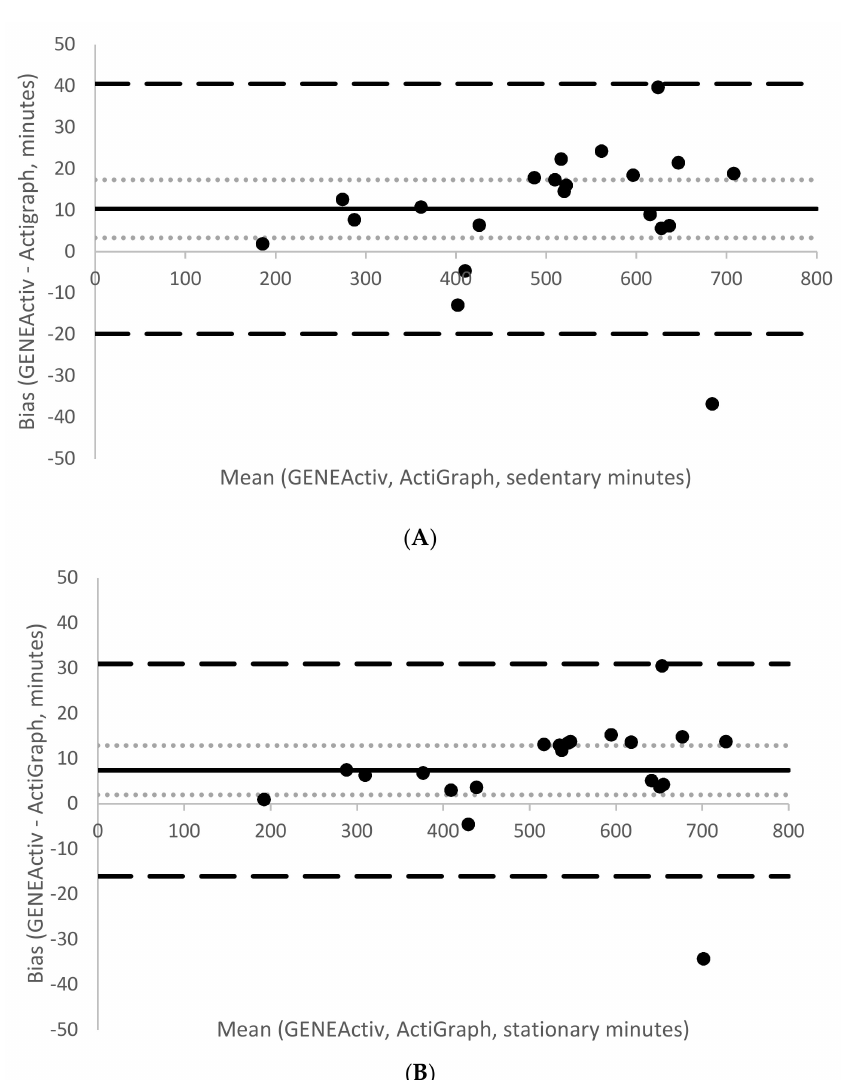
Figure 4. Bland–Altman plots comparing sedentary ( A ) and stationary ( B ) time estimates from the developed cut points between GENEActiv and ActiGraph. The figure displays mean bias (solid line), 95% CI of the mean bias (light dotted lines), and 95% limits of agreement (large dashed